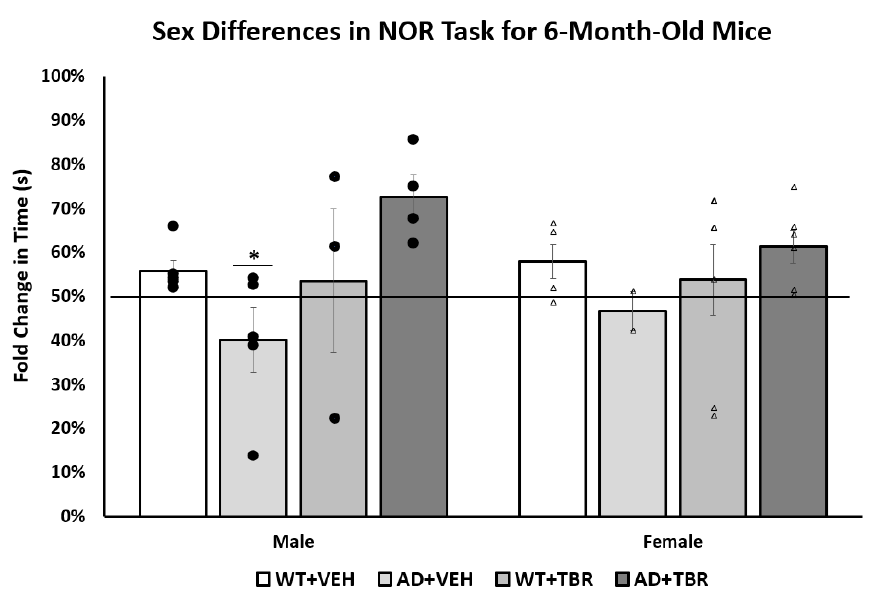
Figure 6. Male TBR-treated 6-month-old 5xFAD mice had fewer memory deficits in the novel object recognition task than female mice. There was a significant difference in the total time spent with the novel object for the 6-month-old male mice. Tukey’s HSD test revealed a significant difference between 5xFAD+VEH animals and 5xFAD+TBR ( p = 0.05). There was no significant difference between the 6-month-old female mice. * p = 0.05 when compared with 5xFAD+VEH with 5xFAD+TBR mice. ( ∆ , female mice; • , male